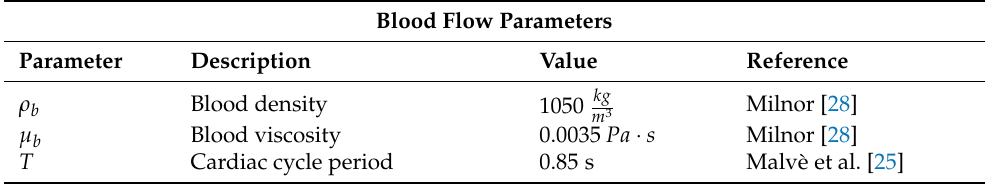
Table 1. Parameters to calculate blood flow.